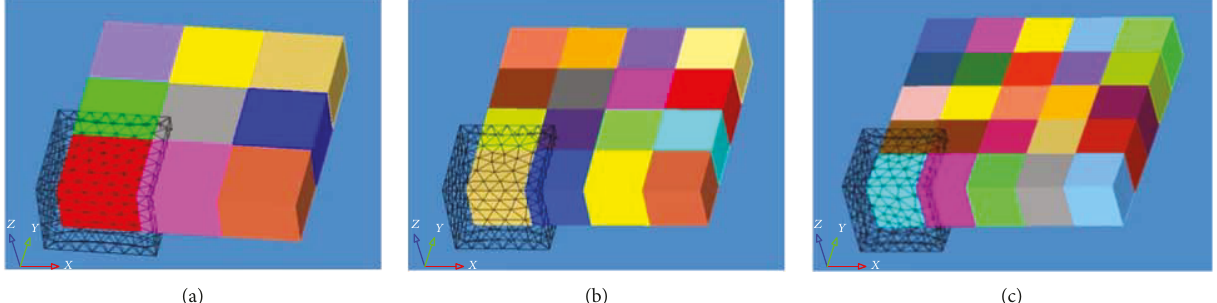
Figure 11: The dielectric slab decomposed into subdomains and each subdomain enclosed by an equivalence surface: (a) 3 × 3 subdomains, (b) 4 × 4 subdomains, and (c) 5 × 5 subdomains.